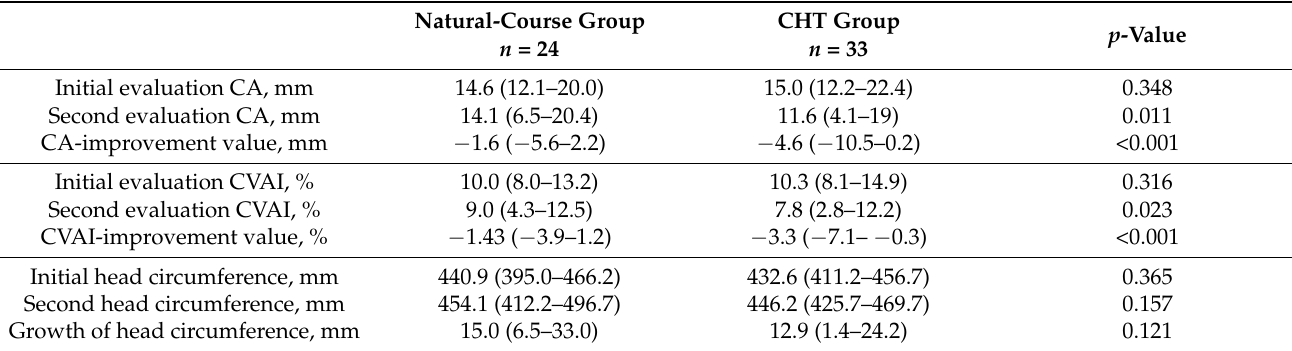
Table 3. Comparisons of CA and CVAI between the natural-course and cranial helmet therapy